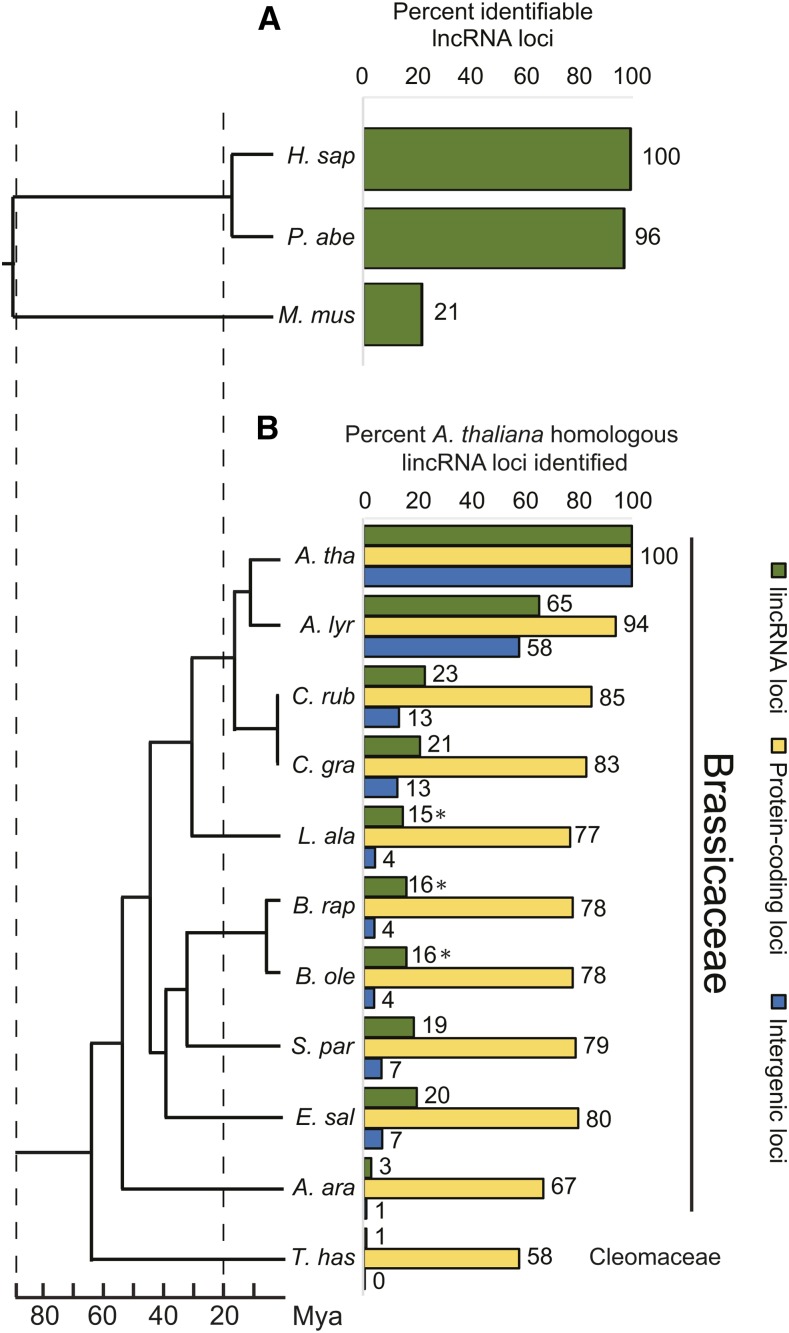
Comparison of conserved homologous lincRNA loci in select mammals and Brassicaceae. (A) Percent of human (H. sap) lncRNA homologs identified in close relatives. Percentage of recovered loci are shown next to each bar. The accepted organismal phylogeny and estimated times of divergence for these three species was derived from Arnason et al. (2008) and is shown to the left to allow for direct comparisons. (B) Percentage of homologous loci recovered for AtlincRNAs (green), genic (yellow) and intergenic (blue) loci using a similar search protocol as that shown for human lncRNAs. Species’ names are abbreviations of those shown in Figure 1A. Percentage is shown next to each bar. Divergence times and species phylogeny was obtained from Beilstein et al. (2010).